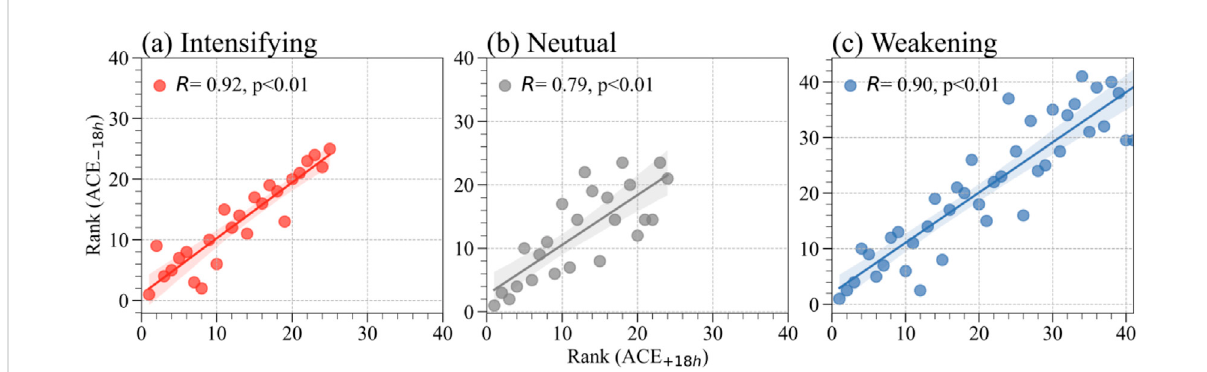
FIGURE 2 Mann-Kendall ’ s tau-b correlation (non-parametric) of the rank between accumulated cyclone energy (ACE) within 18 h prior to landfall ( – 18 h) and 18 h after landfall (+18 h) for (A) intensifying, (B) neutral, and (C) weakening